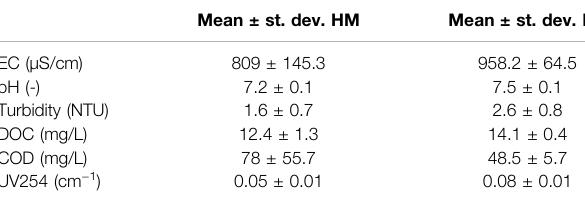
TABLE 1 | Composition of ef fl uent of the secondary clari fi er of WWTP Horstermeer (HM) and WWTP Harnaschpolder (HP), based on four samples analyzed in